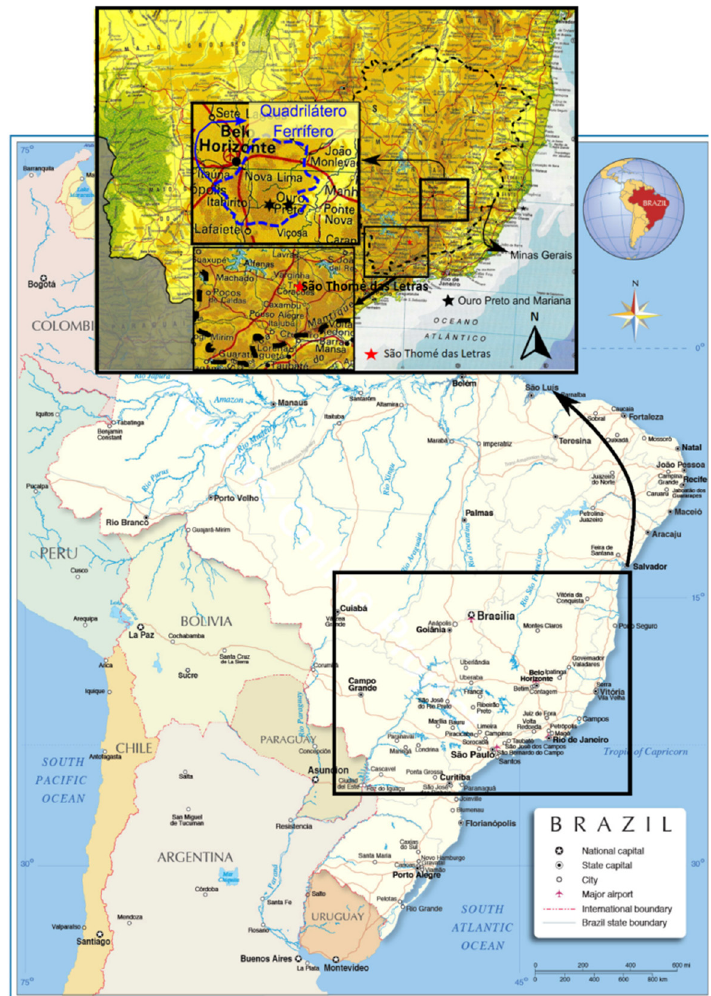
Figure 1. Location of the slopes in Minas Gerais state, Brazil (modified from nationsonline.org (accessed on 22 October